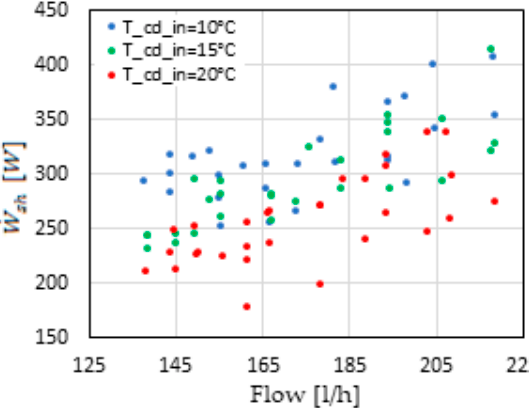
Figure 7. Scroll expander shaft power with flow rate.